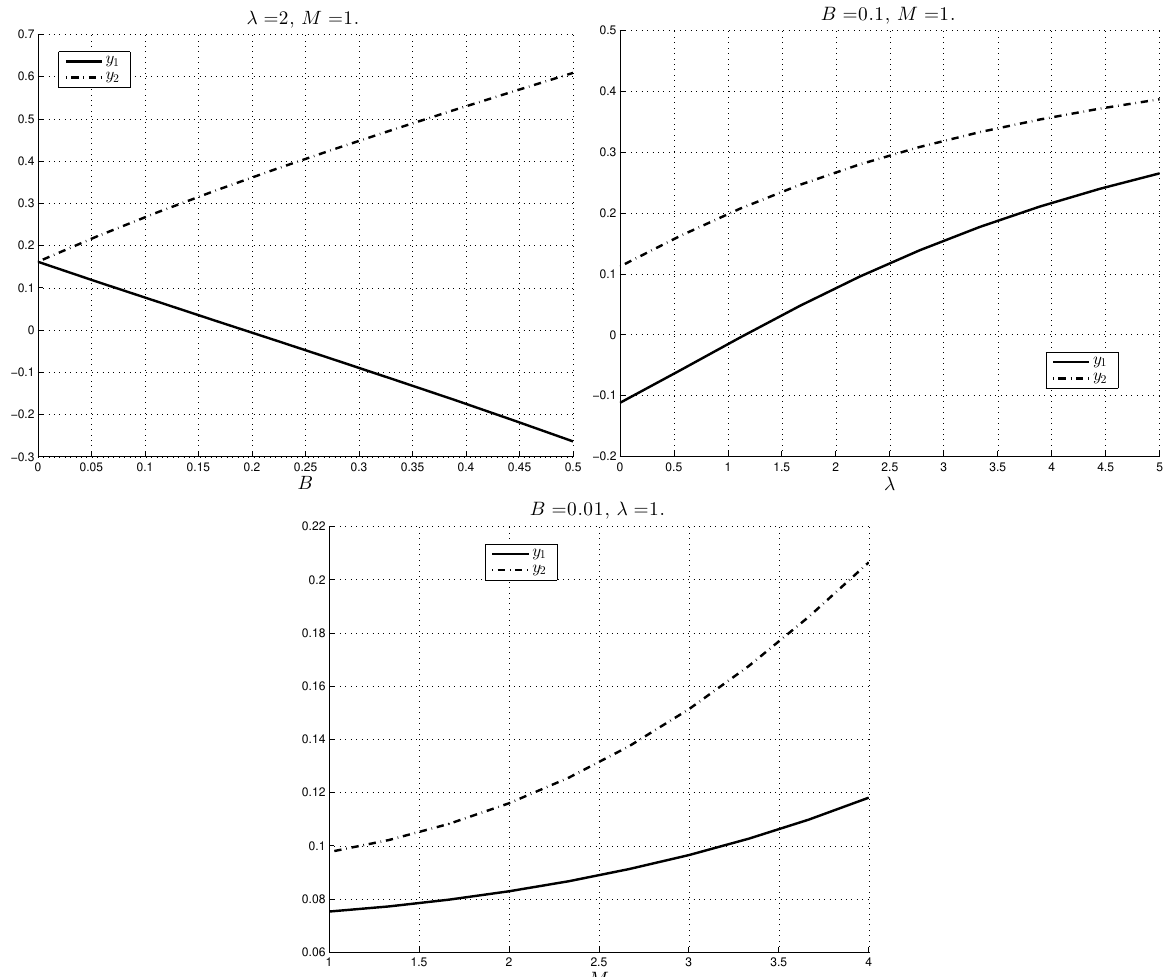
Figure 15. Case 1M : profile of the induced magnetic field. Figure 16 shows the boundaries of the plug regions: we have that y 1 decreases with B and increases with λ , while y 2 increases with B and λ , as in the absence of the external magnetic field. When M increases, y 1 and y 2 increase.